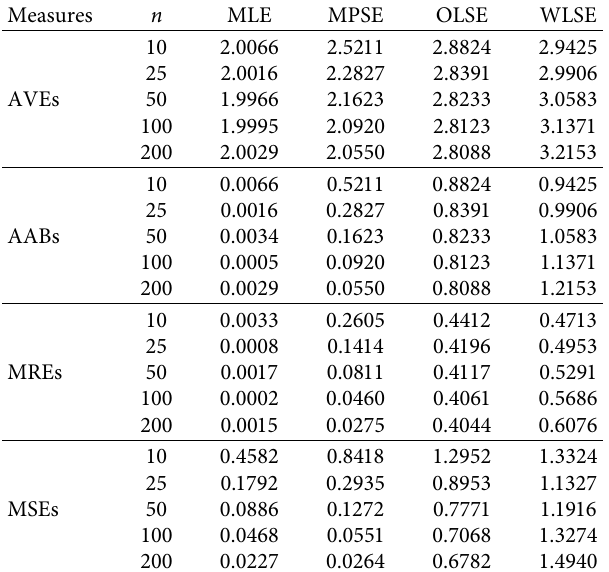
Table 5: Simulation results for β � 2 . 0. Table 7: Simulation results for β � 7 . 0.